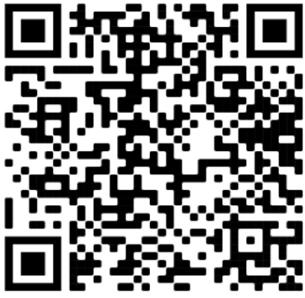
Figure 3. QR code of the category system by progression level (pre-test–post-test).